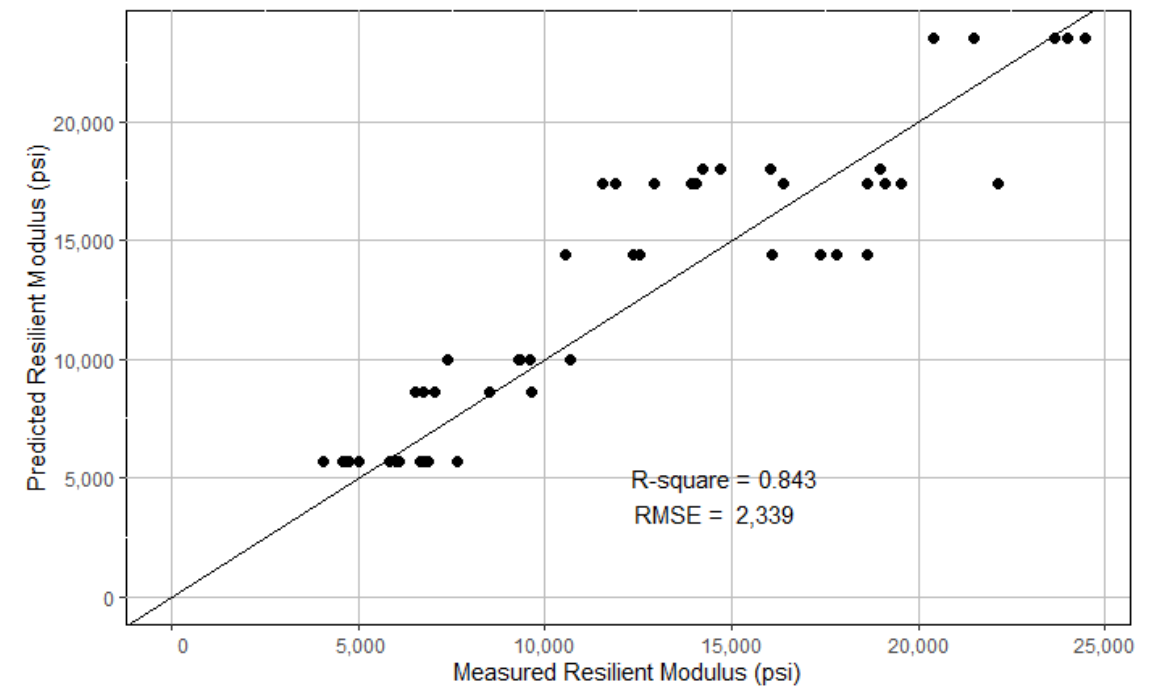
Figure 6. Predicted M R versus measured M R on testing dataset (regression tree model).